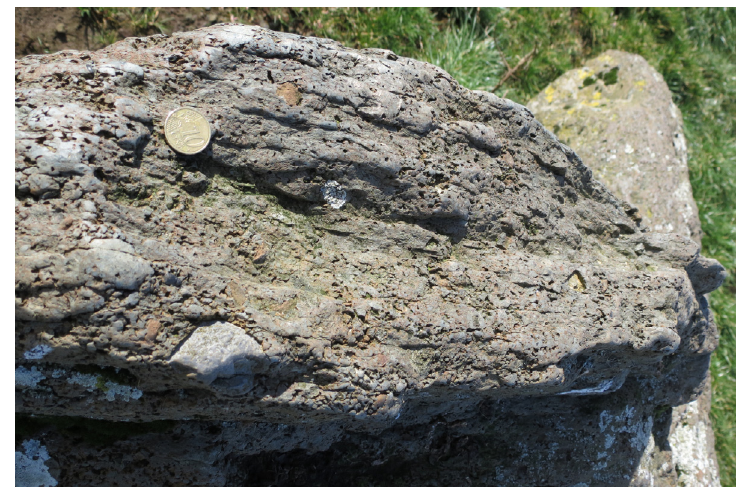
Figure 11. Croghan Hill, County Offaly: Agglomerate rock forms the Clustaka standing